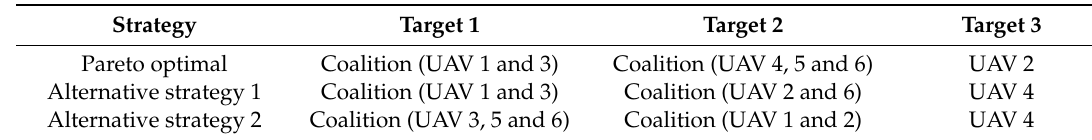
Table 6. The Pareto optimal and alternative strategies.